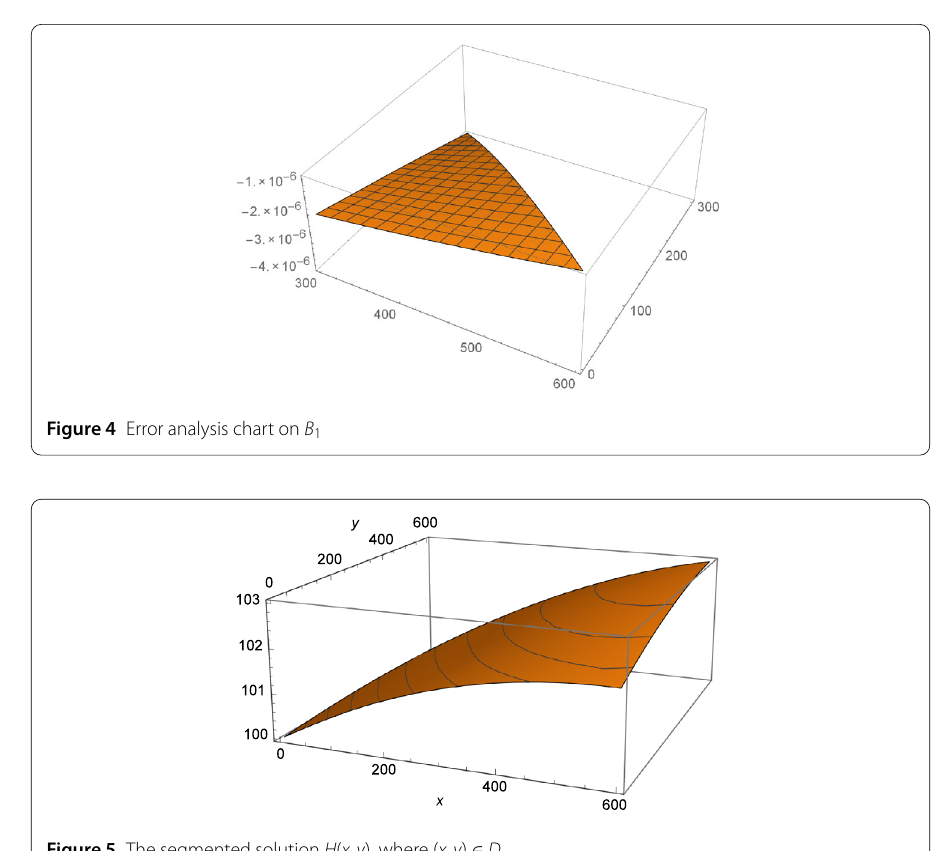
Figure 5 The segmented solution H ( x , y ), where ( x , y ) ∈ D